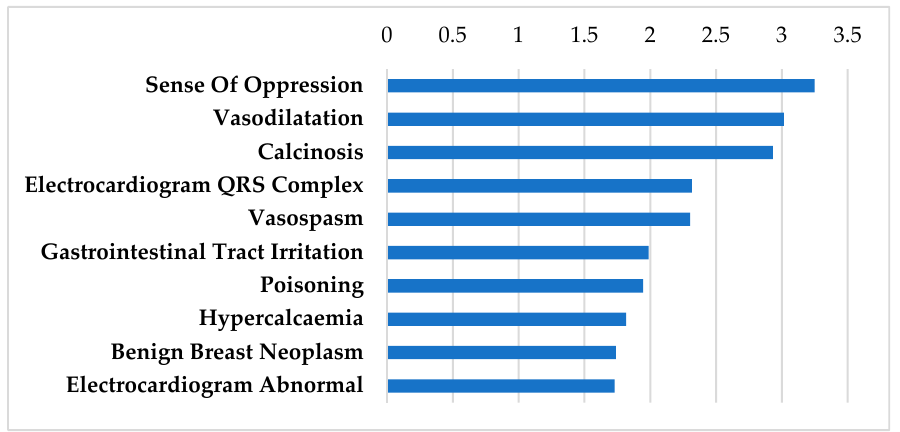
Figure 6. SIDER side effect profile on ion modulators including calcium supplementation and spironolactone. Frequencies of the top 10 side effects shown for the following drugs: calcium citrate, calcium phosphate, and spironolactone based on the negative logarithm of their respective p values. Spironolactone is a mineralocorticoid receptor antagonist used as a potassium-spar- ing diuretic to treat hypokalemia, hyperaldosteronism, and dermatologic conditions as-